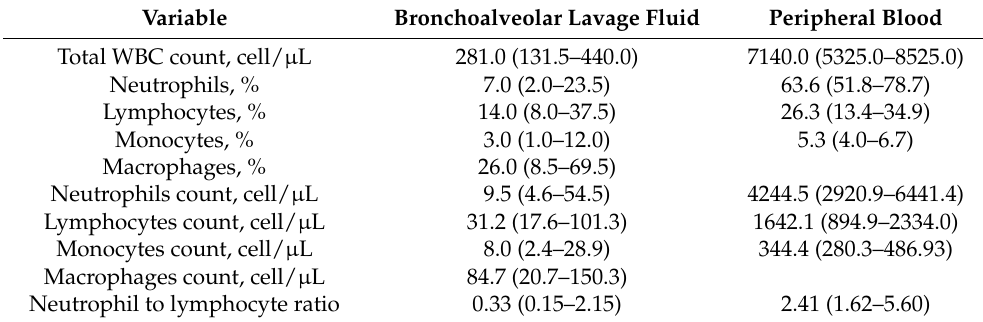
Table 2. Total and differential cell counts in the bronchoalveolar lavage fluid and peripheral blood.